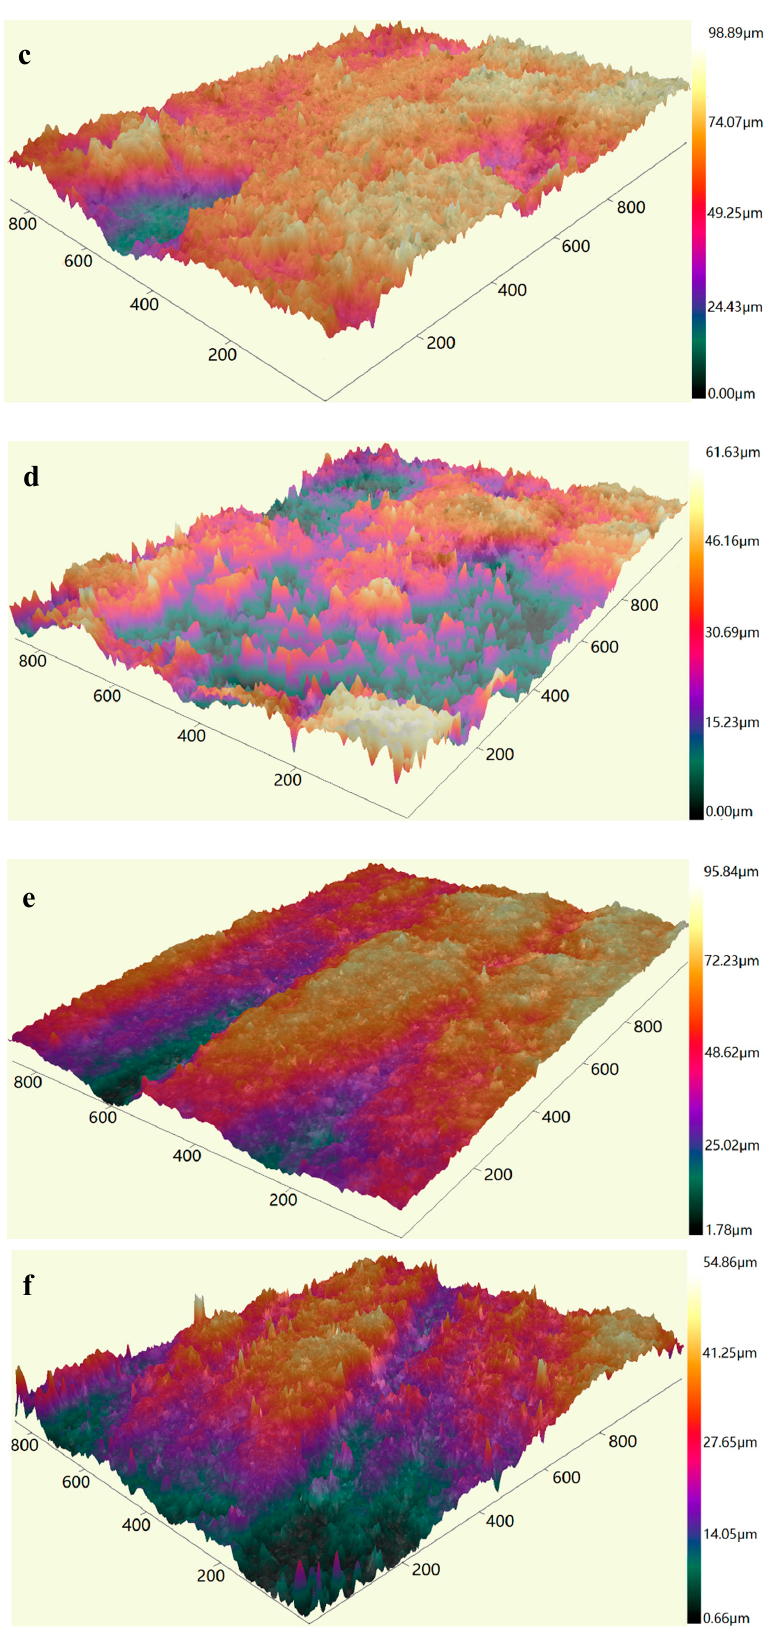
Figure 3. 3-D measurement of specimens. ( a , b ) Before and after test of alloyed steel; ( c , d ) before and after test of sandstone; ( e , f ) before and after test of shale. Table 1. Information about measurement of surface.